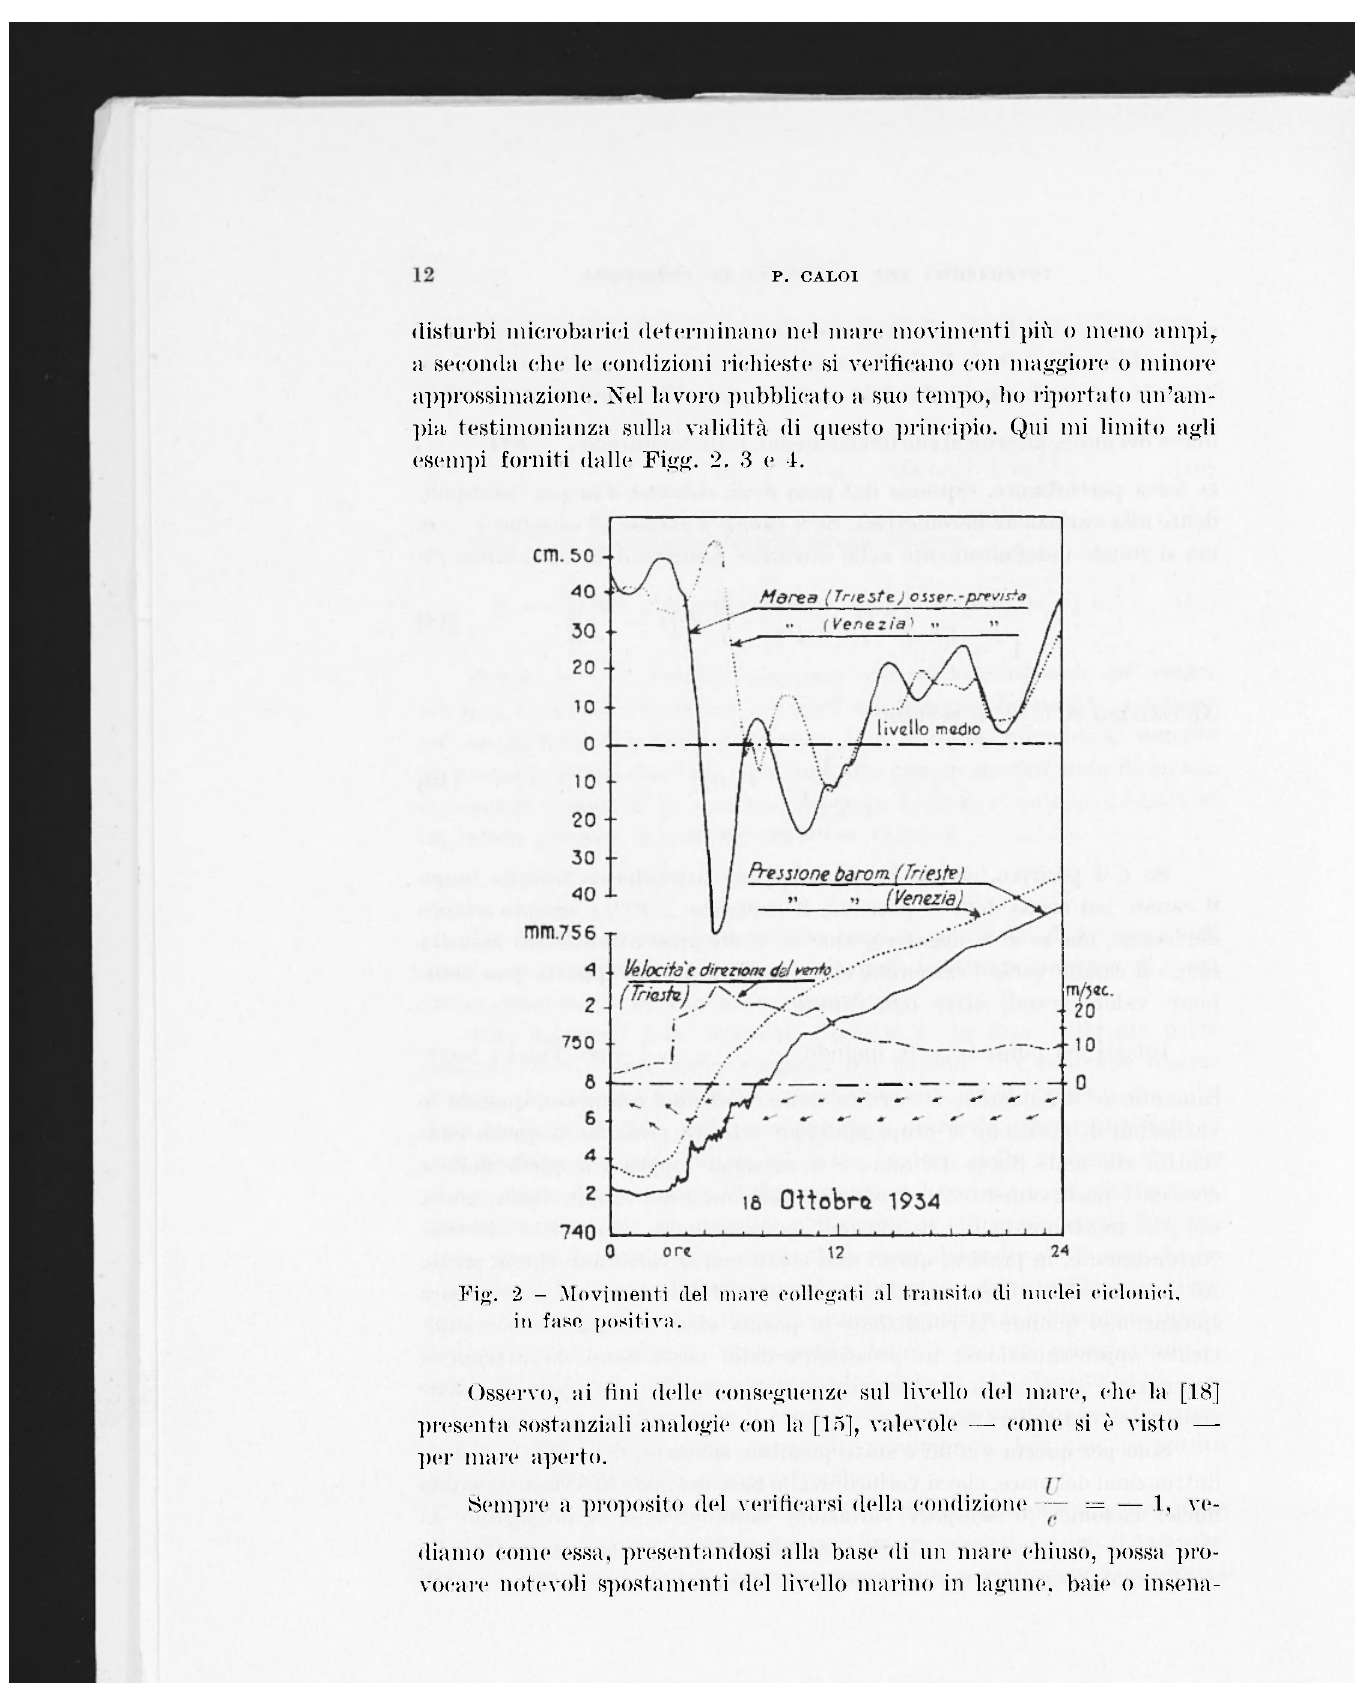
Fig. 2 - Movimenti del mare collegati al transito di nuclei ciclonici, in fase